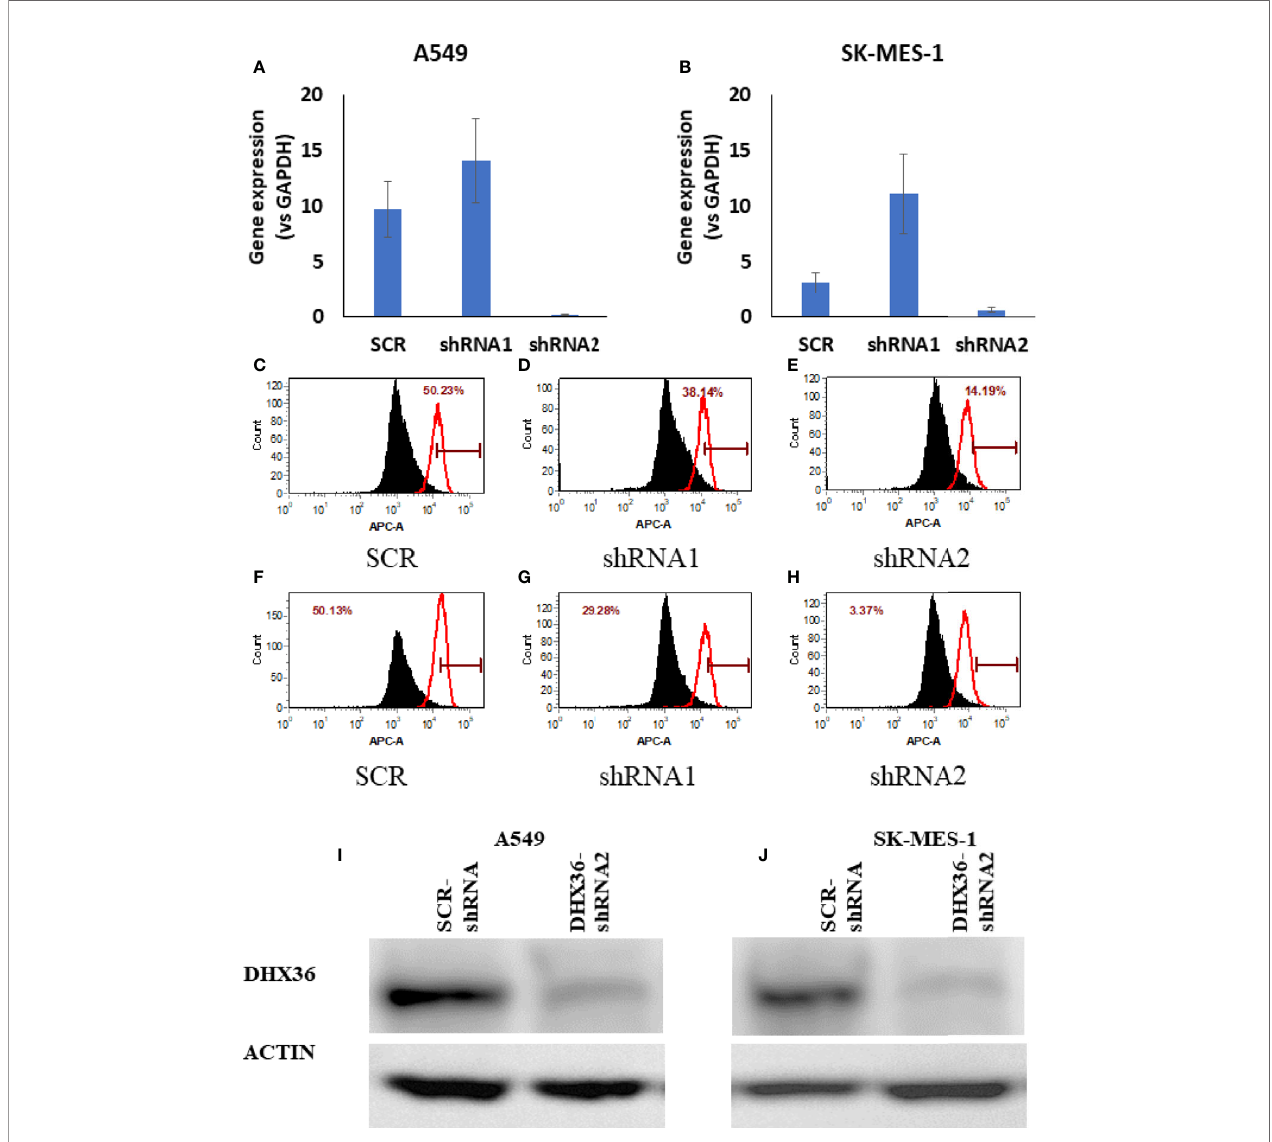
FIGURE 2 | Validation of the stable cell lines with DHX36 shRNAs. Gene expression in A549 (A) and SK-MES-1 (B) . Flow cytometry analysis of DHX36 protein expression in A549 containing SCR (C) , A549 containing DHX36 shRNA1 (D) , A549 containing DHX36 shRNA2 (E) , SK-MES-1 containing SCR (F) , SK-MES-1 containing DHX36 shRNA1 (G) , SK-MES-1 containing DHX36 shRNA1 (H) . Western blots of DHX36 protein in A549 (I) and SK-MES-1 (J)